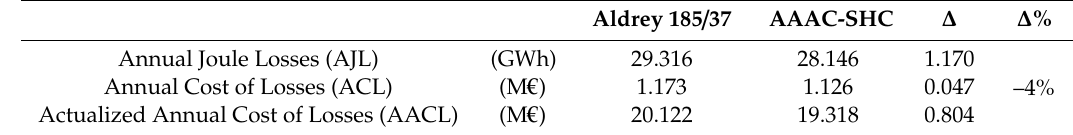
Table 14. Comparison between traditional and innovative conductors for HV OHLs.